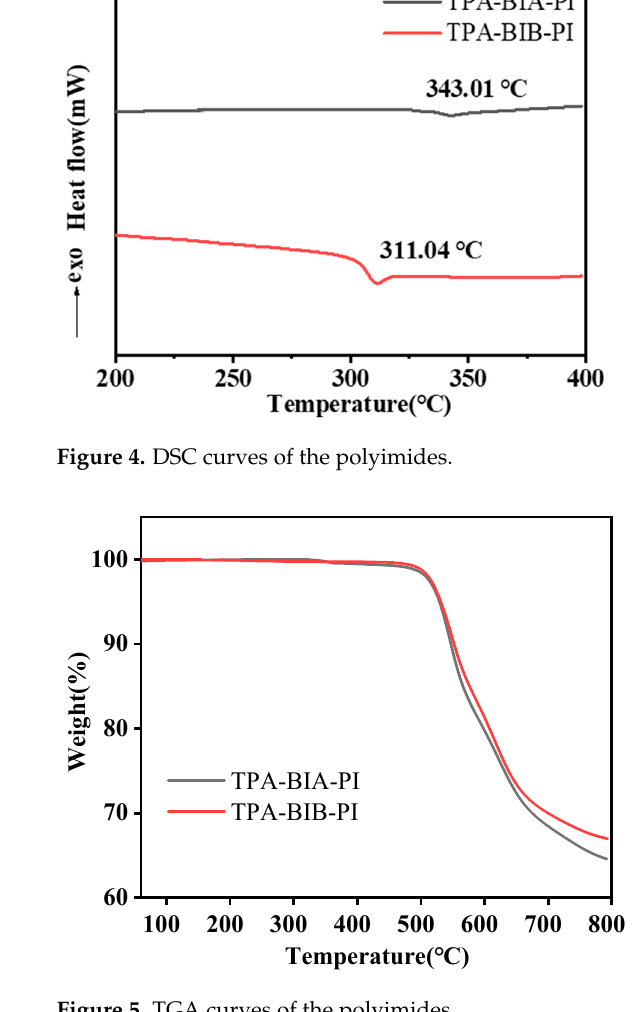
Figure 5. TGA curves of the polyimides. Table 2. Thermal properties of the Polyimides.